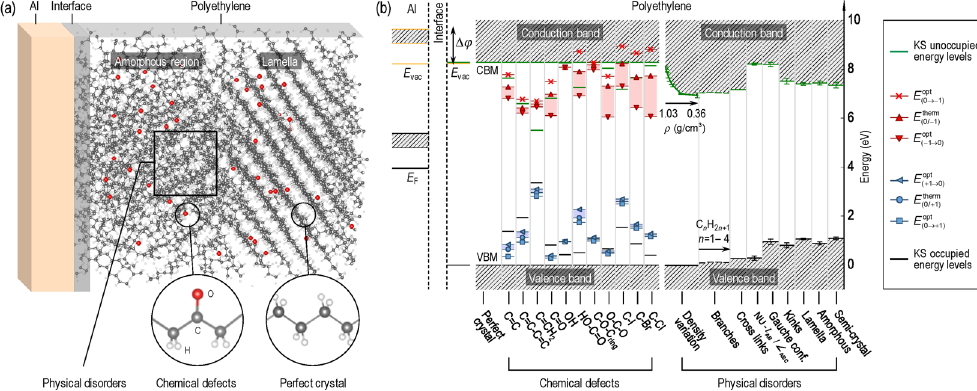
Figure 1. ( a ) Schematic structure of an Al/PE interface, containing crystalline and amorphous regions, and populations of chemical defects. Here, C, H, and O atoms are shown in black, white, and red, respectively. ( b ) Electronic structure of Al/PE interfaces and bulk PE with imperfections. E vac , Δ ϕ , E F , CBM and VBM are the vacuum level, the vacuum energy shift, the Fermi level of Al, and the conduction band minimum and the valence band maximum of PE, respectively. Error bars of VBM and CBM are obtained by determining the standard deviations from 10 different configurations considered for each disorder/defect. Shaded region of E vac is induced by the O-containing groups at Al/PE interfaces. ± E optical charge transition levels. All energy levels are with respect to the average C-1 s core level of the perfect crystal PE whose VBM is set to 0